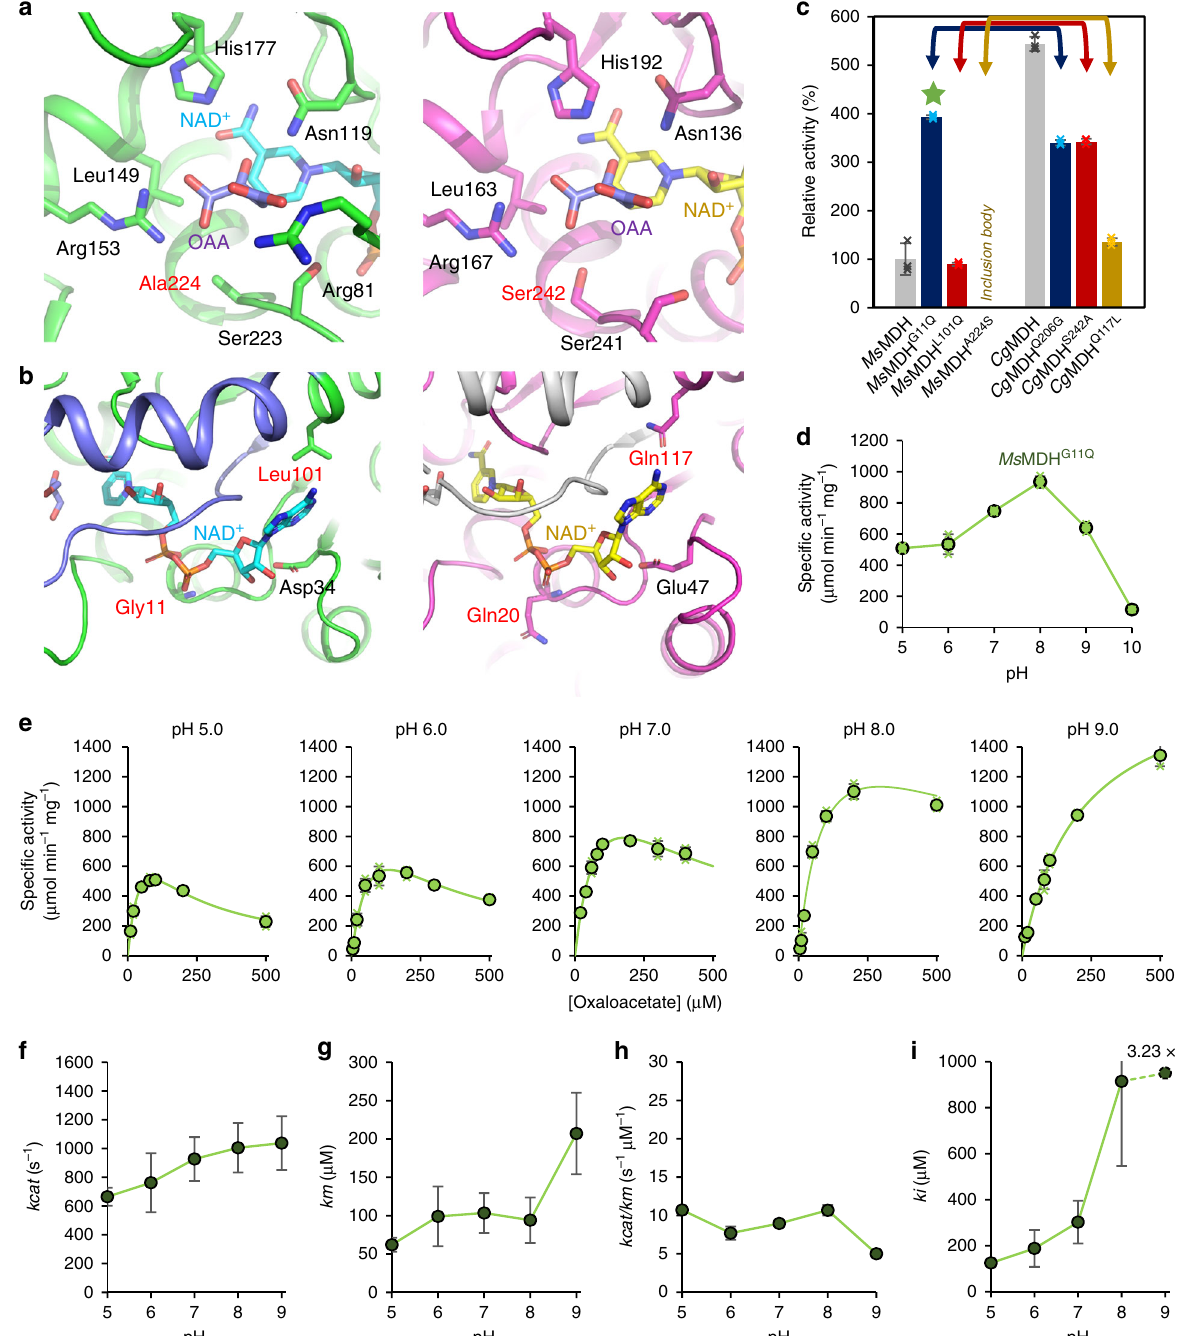
Fig. 2 Development of highly ef fi cient Ms MDH G11Q variant based on structural comparison between Ms MDH and Cg MDH. a The OAA/malate binding site and b NADH/NAD + binding site of the two crystal structures; Ms MDH (left, green model) and Cg MDH (right, magenta model). The conformation of OAA is obtained from a superimposed structure of Methylobacterium extorquens MDH (PDB code 4ROS). The mobile loop is distinguished by different color schemes of light blue ( Ms MDH) and gray ( Cg MDH). The observed residual differences are indicated by red color. c Site-directed mutagenesis and the relative activities of the Ms MDH and Cg MDH variants in comparison with the activity of Ms MDH ( n = 3 independent experiments). Data are presented as mean values ± standard deviation. Each of the corresponding variants are indicated by the same color scheme and arrow. The Ms MDH A224S variant, which is labeled as ‘ Inclusion body ’ , was expressed insoluble. The Ms MDH G11Q variant is indicated by a green star. d Optimal pH of the Ms MDH G11Q variant ( n = 3 independent experiments). Data are presented as mean values ± standard deviation. The speci fi c activity at pH 10.0 was determined from a single data. e Catalytic performance of the Ms MDH G11Q variant at different pH ( n = 3 independent experiments). Data are presented as mean values ± standard deviation. f kcat , g km , h kcat/km , and i ki values of the Ms MDH G11Q variant at different pH. The ki value of the Ms MDH G11Q variant at pH 9.0 is shown in number because its value is signi fi cantly higher than the rest of the ki values. Data f – i are presented as parameters ± standard error. The standard